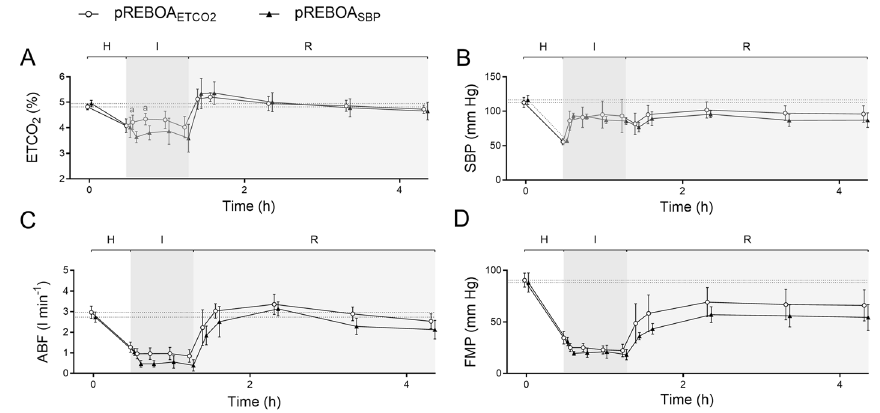
Fig. 4 Arterial and mesenteric venous lactate ( A , B ) and potassium (K; C , D ) concentrations in anesthetized, mechanically ventilated pigs undergoing hemorrhage (H), intervention (I) by end-tidal carbon dioxide (ETCO 2 ) targeted partial resuscitative endovascular balloon occlusion of the aorta (pREBOA, pREBOA ETCO2 , n 10) and proximal systolic blood pressure targeted pREBOA (pREBOA SBP , n = reperfusion (R). a Denotes statistical difference between the groups at given timepoint. Data are means (95% confidence interval). The dotted line represents baseline